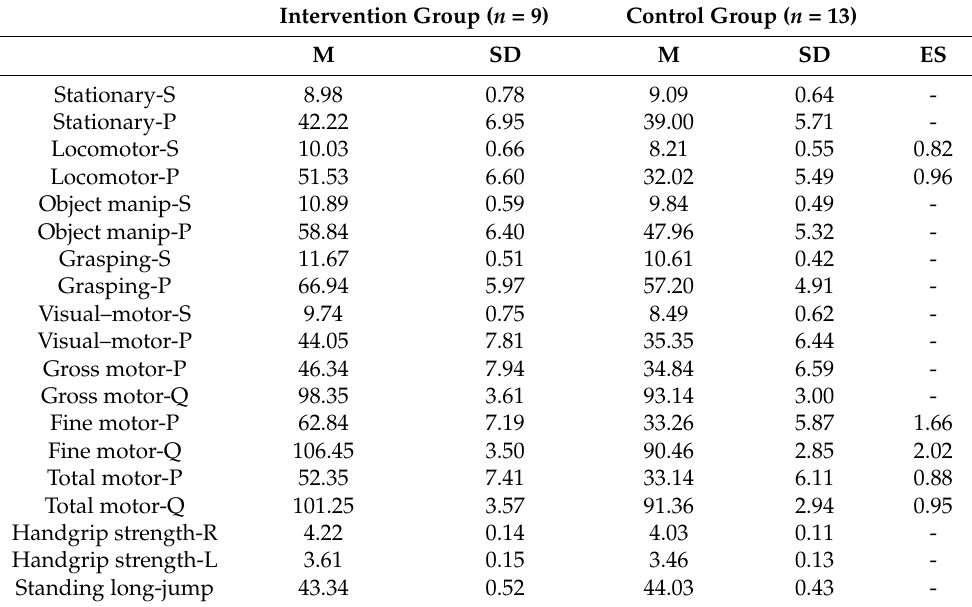
Table 4. Adapted post-test means calculated with an ANCOVA with the pre-test as a co-variable.